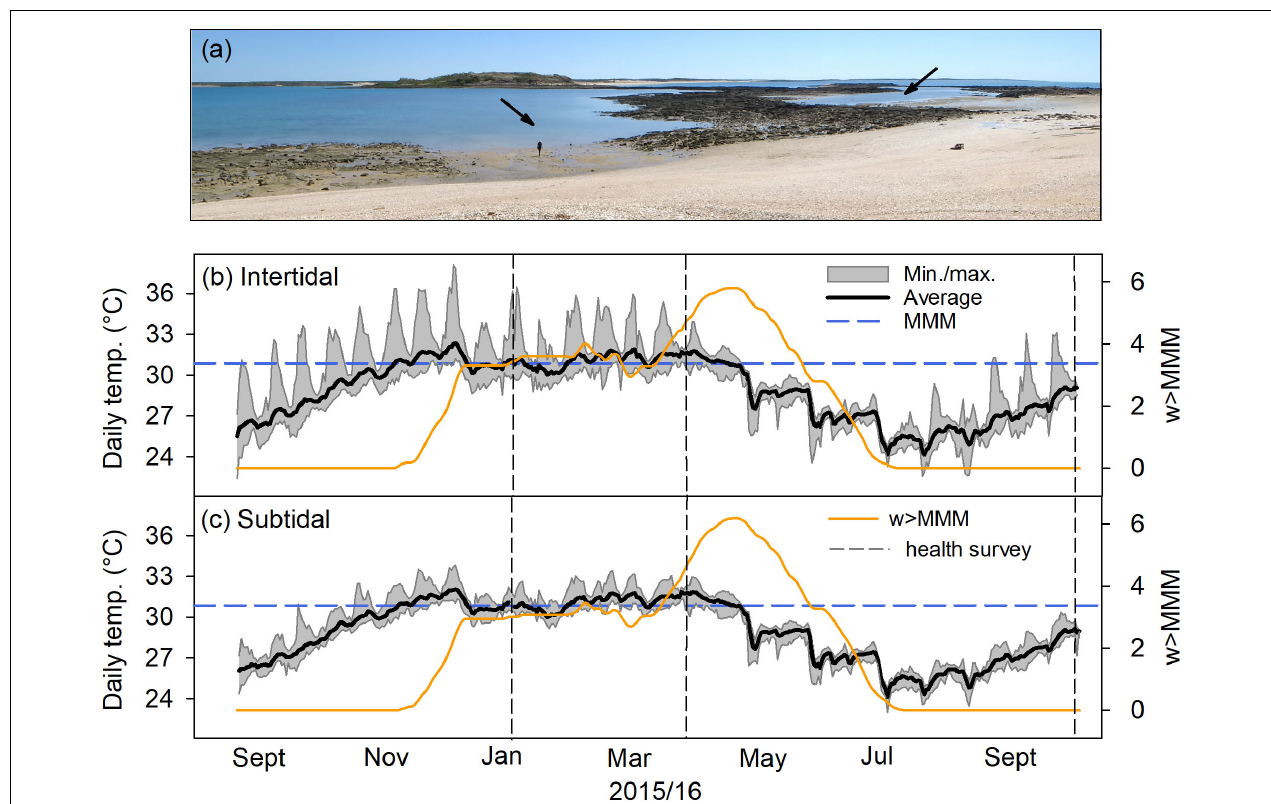
FIGURE 1 | Temperature and heat stress exposure at intertidal and subtidal environments. (a) The subtidal (arrow center left) and intertidal (arrow upper right) at Shell Island, Kimberley region at mid- to low tide. Arrow indicated approximate area where surveys and coral collection was conducted. (b) Daily average, minimum, and maximum temperature in the intertidal from September 1, 2015 to October 18, 2016. The blue dashed lines show the local maximum monthly mean (MMM) temperature. Orange solid lines indicate weekly cumulative heat stress above the local MMM (w > MMM; see section “Materials and Methods”). Vertical dashed lines indicate when coral health was assessed in reef-wide surveys. (c) Same as in (b) but for the